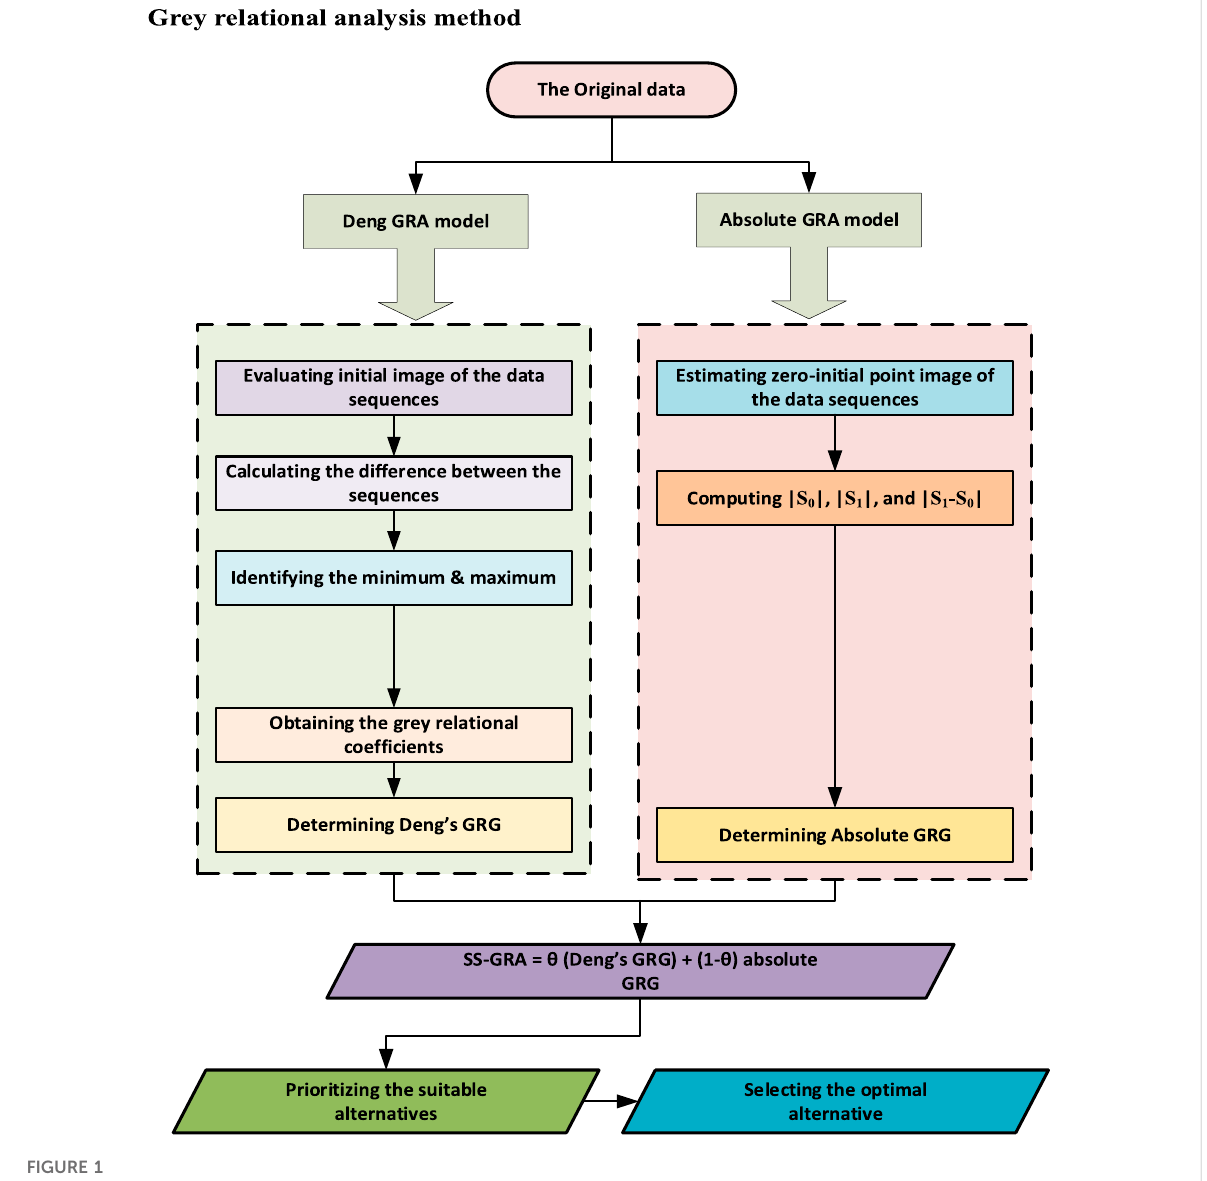
FIGURE 1 The proposed grey methodology framework utilized in the